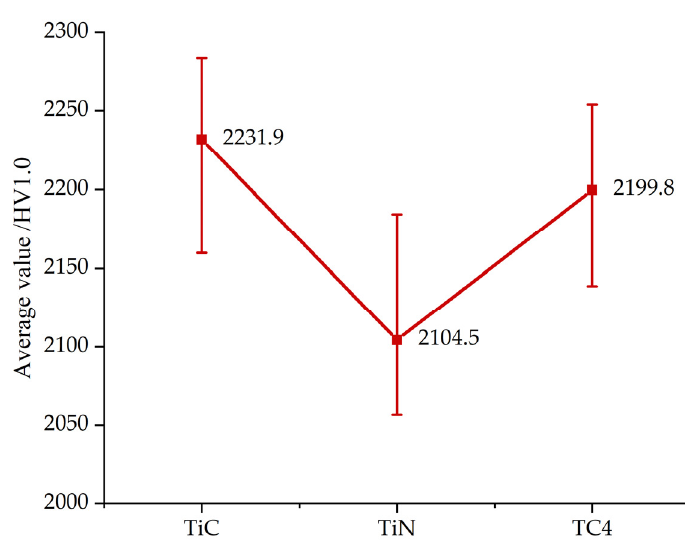
Figure 15. Deposition layer hardness measurement results.